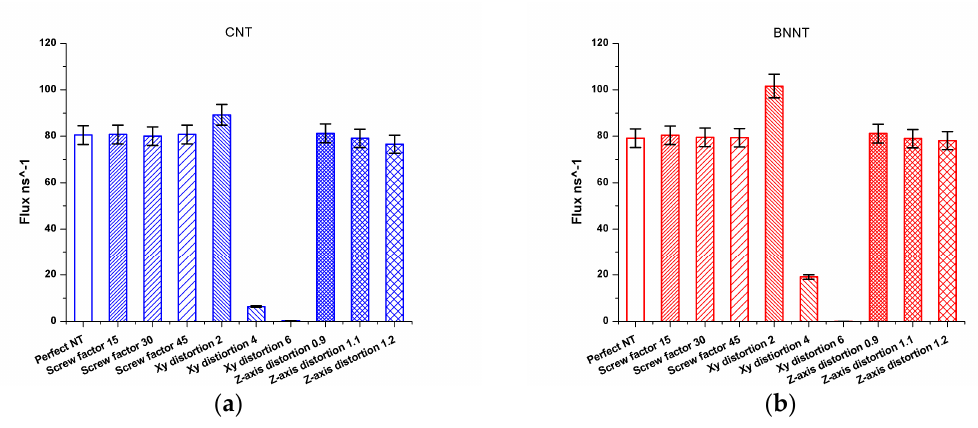
Figure 6. Variation of flux in perfect and different deformed nanotubes: ( a ) carbon nanotube (CNT) and ( b ) boron nitride nanotube (BNNT).